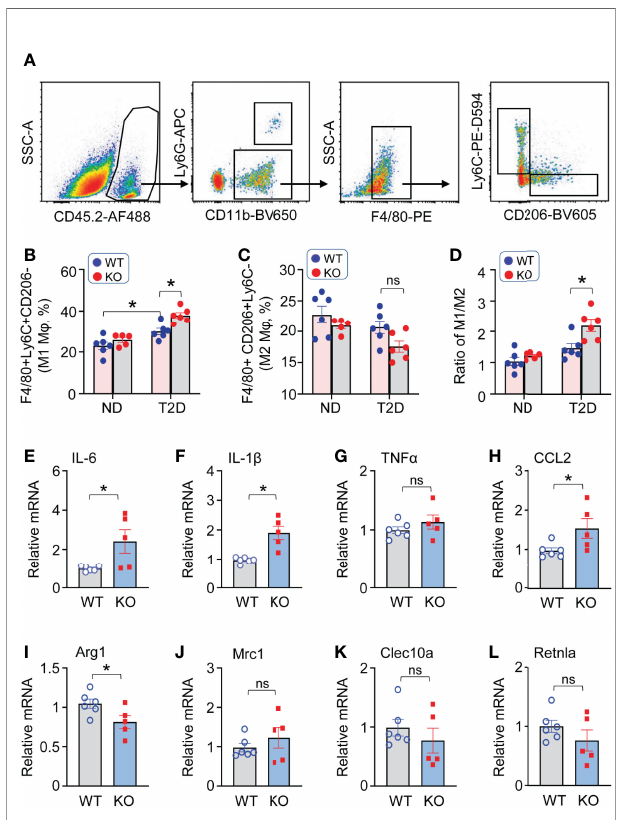
FIGURE 4 | Lcn10 de fi ciency promotes macrophage pro-in fl ammatory M1-like phenotype in T2D hearts. (A – D) Cardiac macrophage phenotypes were determined in the heart of ND and T2D mice at 1-week post-STZ. Representative fl ow cytometry plots and gating strategy were shown for cardiac macrophages (A) , quanti fi cation of cardiac pro-in fl ammatory M1-like macrophages (F4/80+Ly6C +CD206-) (B) , anti-in fl ammatory M2-like macrophages (F4/80+Ly6C-CD206+) (C) and the ratio of M1/M2 (D) (* P < 0.05, n = 5-6 mice per group). (E – L) qRT-PCR analysis of mRNA expression of pro-in fl ammatory marker genes (IL-6, IL-1 b , TNF a , CCL2) (E – H) and anti-in fl ammatory marker genes (Arg1, Mrc1, Clec10a, Retnla) (I – L) in cardiac macrophages isolated from the heart of WT and Lcn10-KO mice at 1 week post-STZ injection (* P < 0.05, n = 5-6 mice per group). All data are presented as mean ± SEM and analyzed by two-way ANOVA (B – D) or student ’ s t-test (E – L) ns, non signi fi